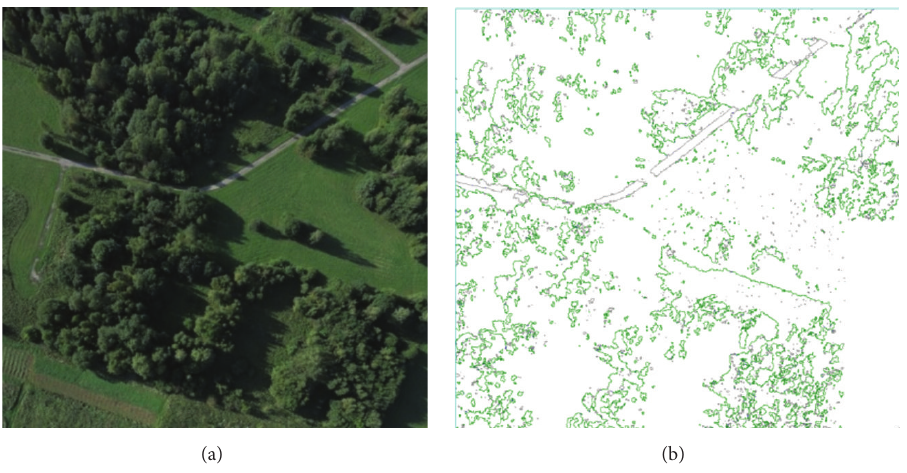
Figure 12: Automatic fixation of the target by Envi Ex program.